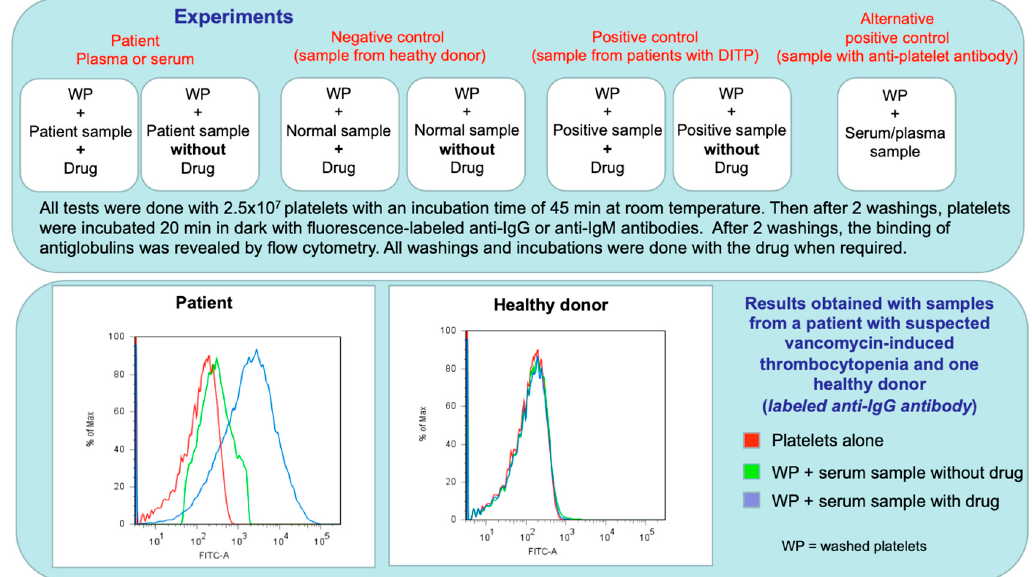
Figure 3. Example of flow cytometry analysis applied for the diagnosis of DITP due to vancomycin. Results obtained are shown in the lower panel. The procedure used was adapted from Curtis et al. [43]. Abbreviations: DITP: drug-induced immune thrombocytopenia; WP: washed platelets.